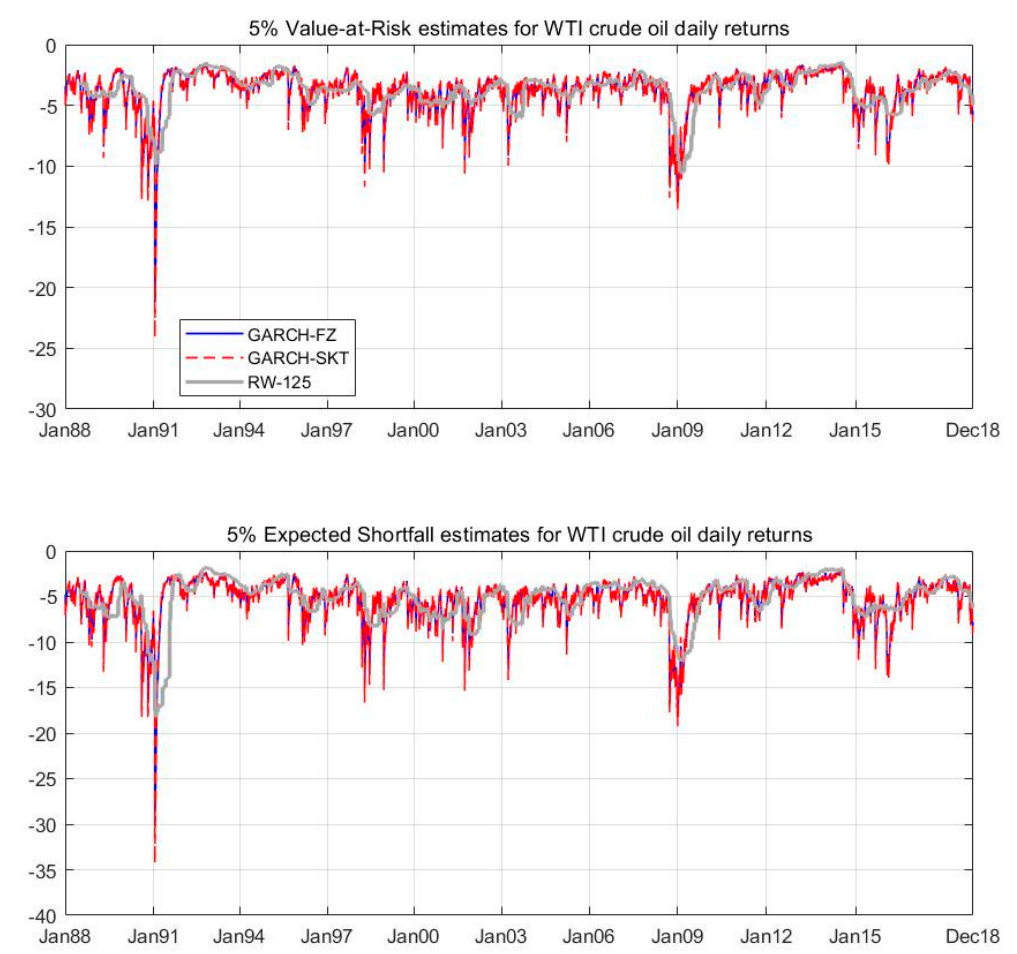
Figure 2. The estimated 5% VaR and ES values for the daily returns on the WTI crude oil price for the period of January 1988 to December 2018. The estimates were based on a one-factor GAS model, a GARCH model, and a rolling-window model, using 125 observations.